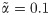
Resilience to drop-off for various choices of initiation and termination rates, computed analytically (solid lines) and numerically (dots) for L = 1.The blue line represents a mRNA sequence in the low density regime, with α˜=0.1
β˜=1. The red line corresponds to a sequence starting in the high density regime with α˜=1, β˜=0.1. The maximal current regime is represented by the green line with α˜=1 and β˜=1.